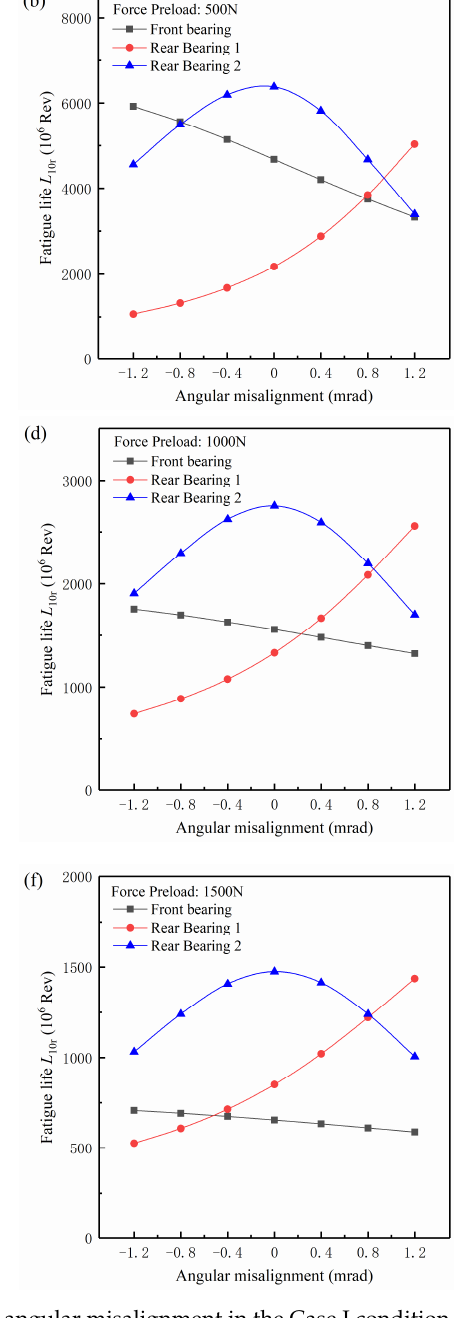
Figure 13. The variation of the bearing life with the angular misalignment in the Case I condition (( a ), ( c ) and ( e )) and in the Case II condition (( b ), ( d ) and ( f )) for constant-force preload.